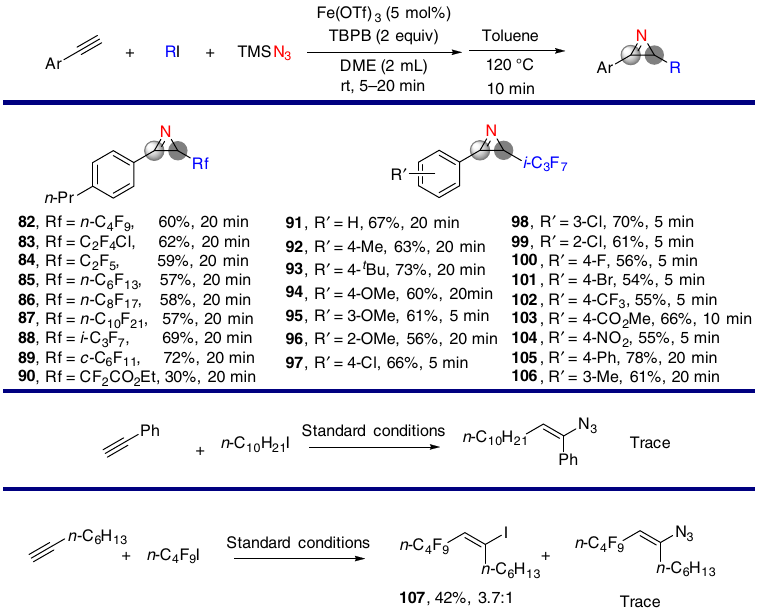
Fig. 7 Substrate scope of carboazidation of alkynes and further transformation to 2 H -azirines. General reaction conditions: Fe(OTf) 3 (0.025mmol), alkyne (0.5mmol), RI (0.75mmol), TMSN 3 (1.0mmol), TBPB (1.0mmol) in DME (2mL) at rt for 5 – 20min and then in toluene at 120°C for 10min under an N 2 atmosphere. Isolated